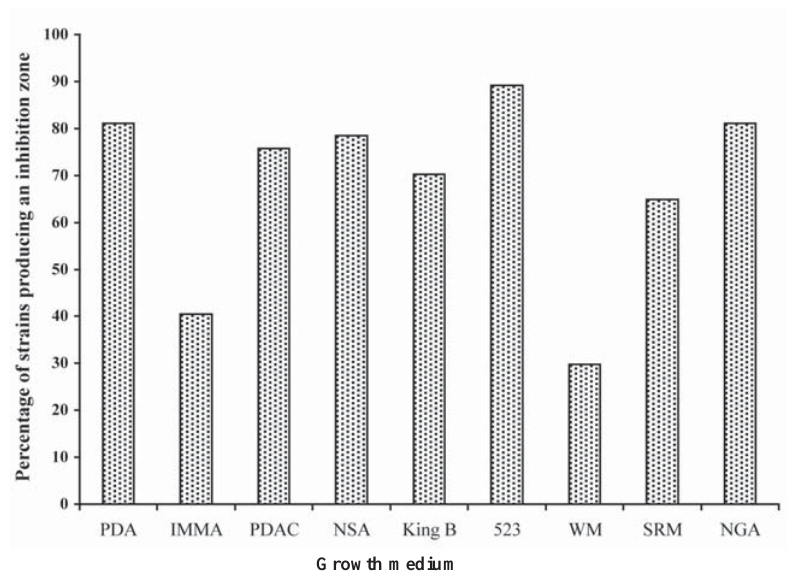
Fig. 1. Inhibition zone against Bacillus megaterium produced by 33 pathovars of Pseudomonas syringae and 4 strains of P. avellanae on 9 different substrates growth